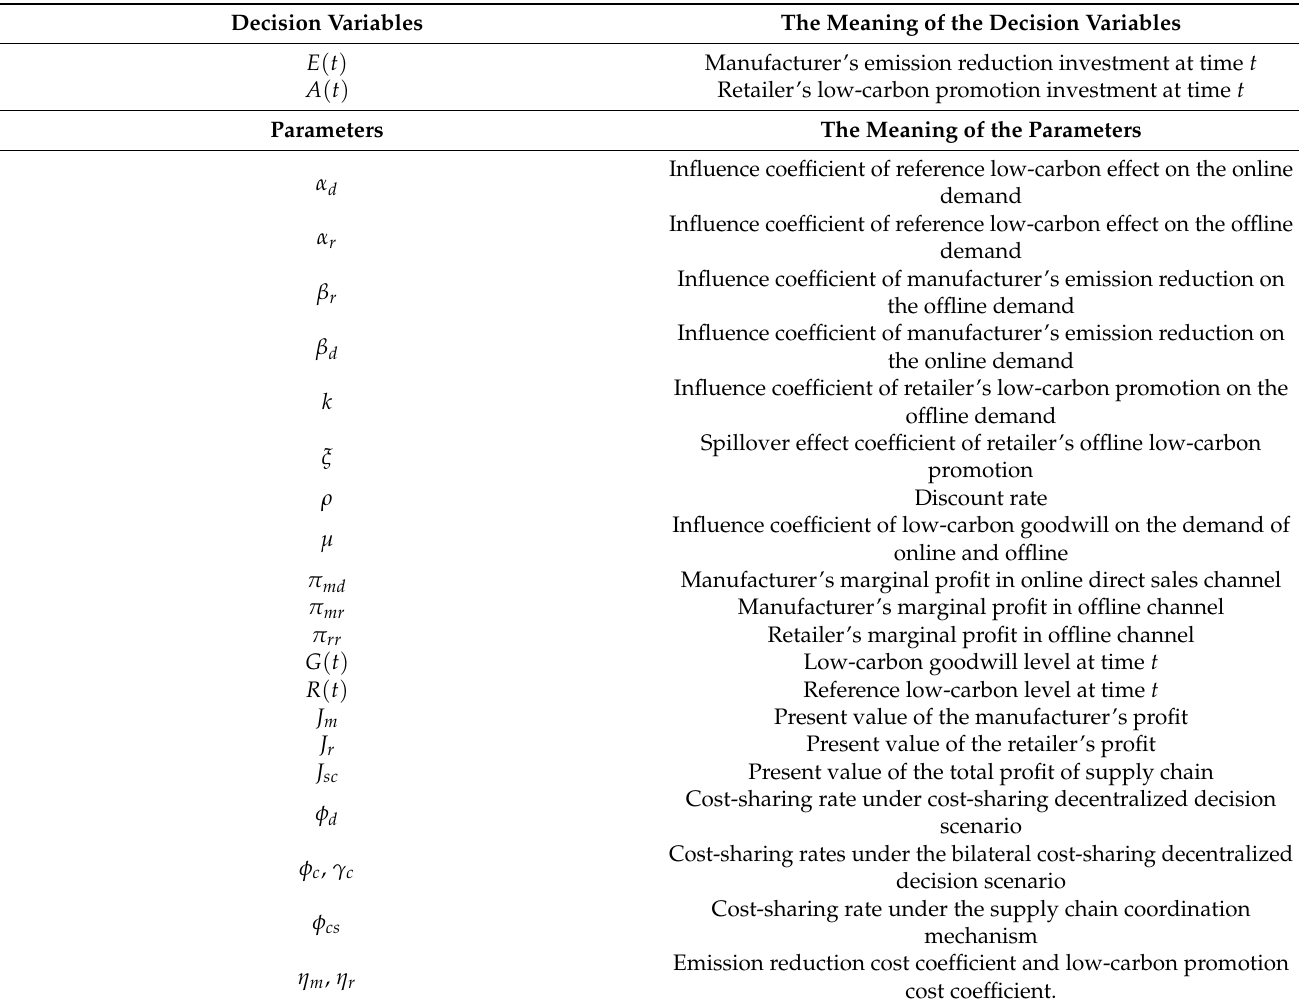
Table 2. Decision variables and major